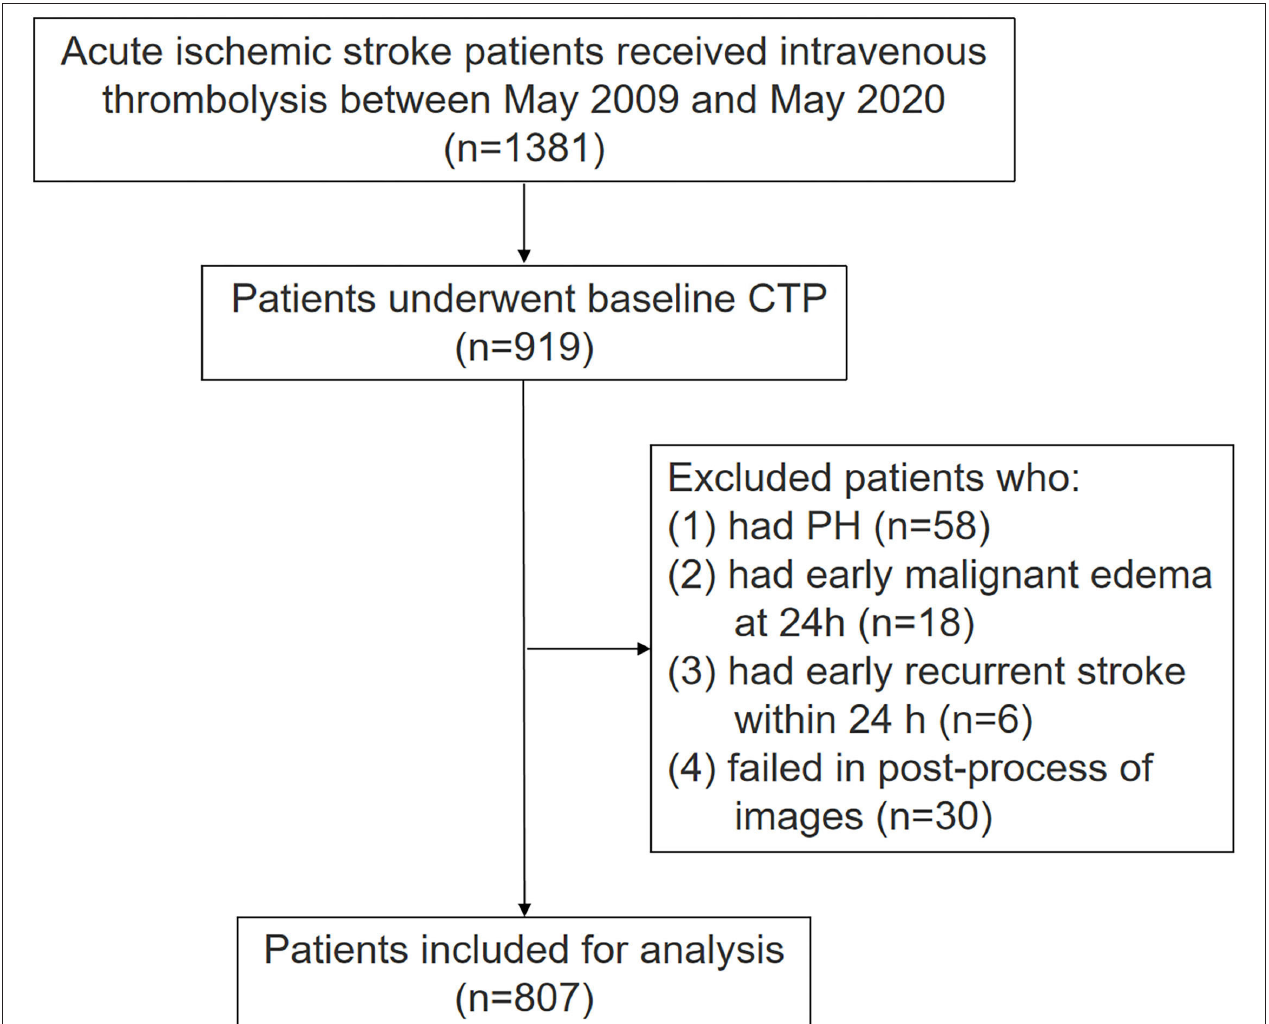
FIGURE 2 | Patients flow